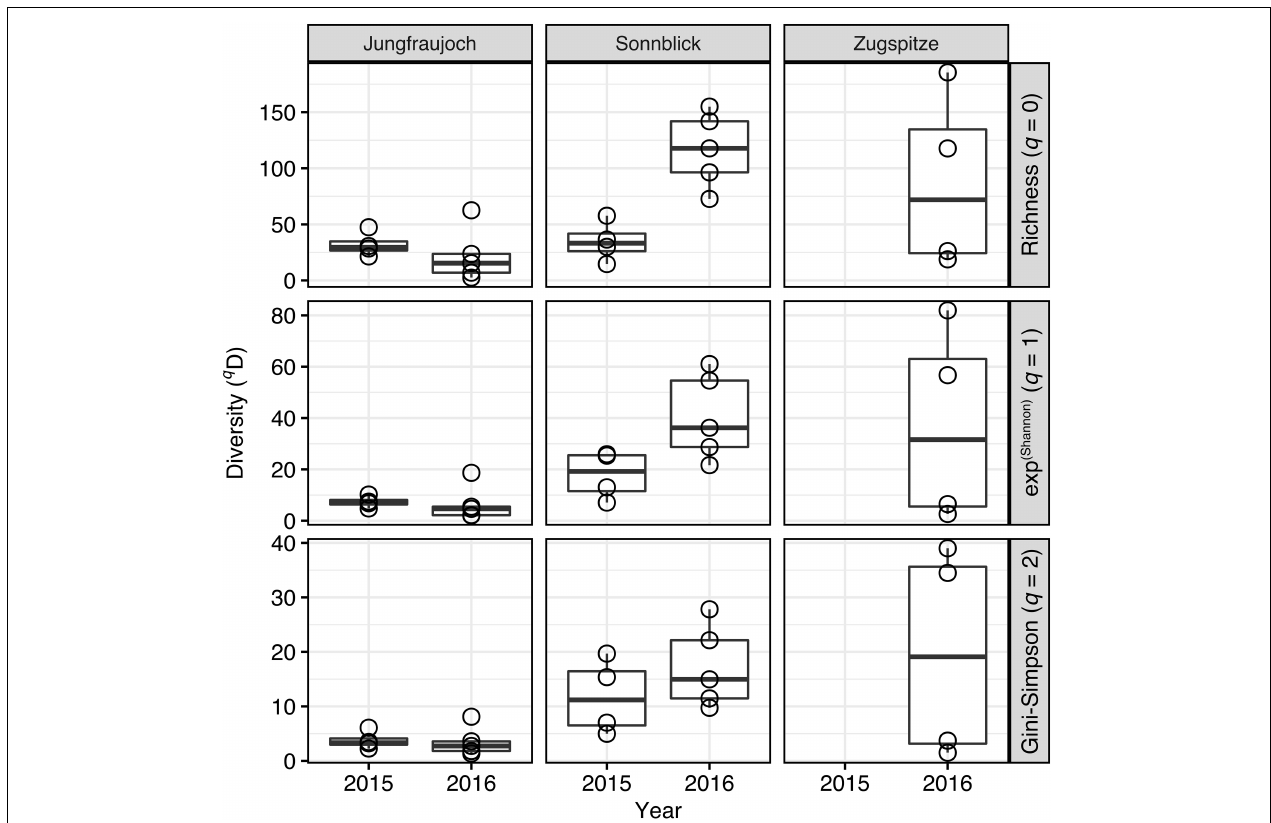
FIGURE 7 | Microbial community alpha diversity estimates inferred from Hill numbers per site and